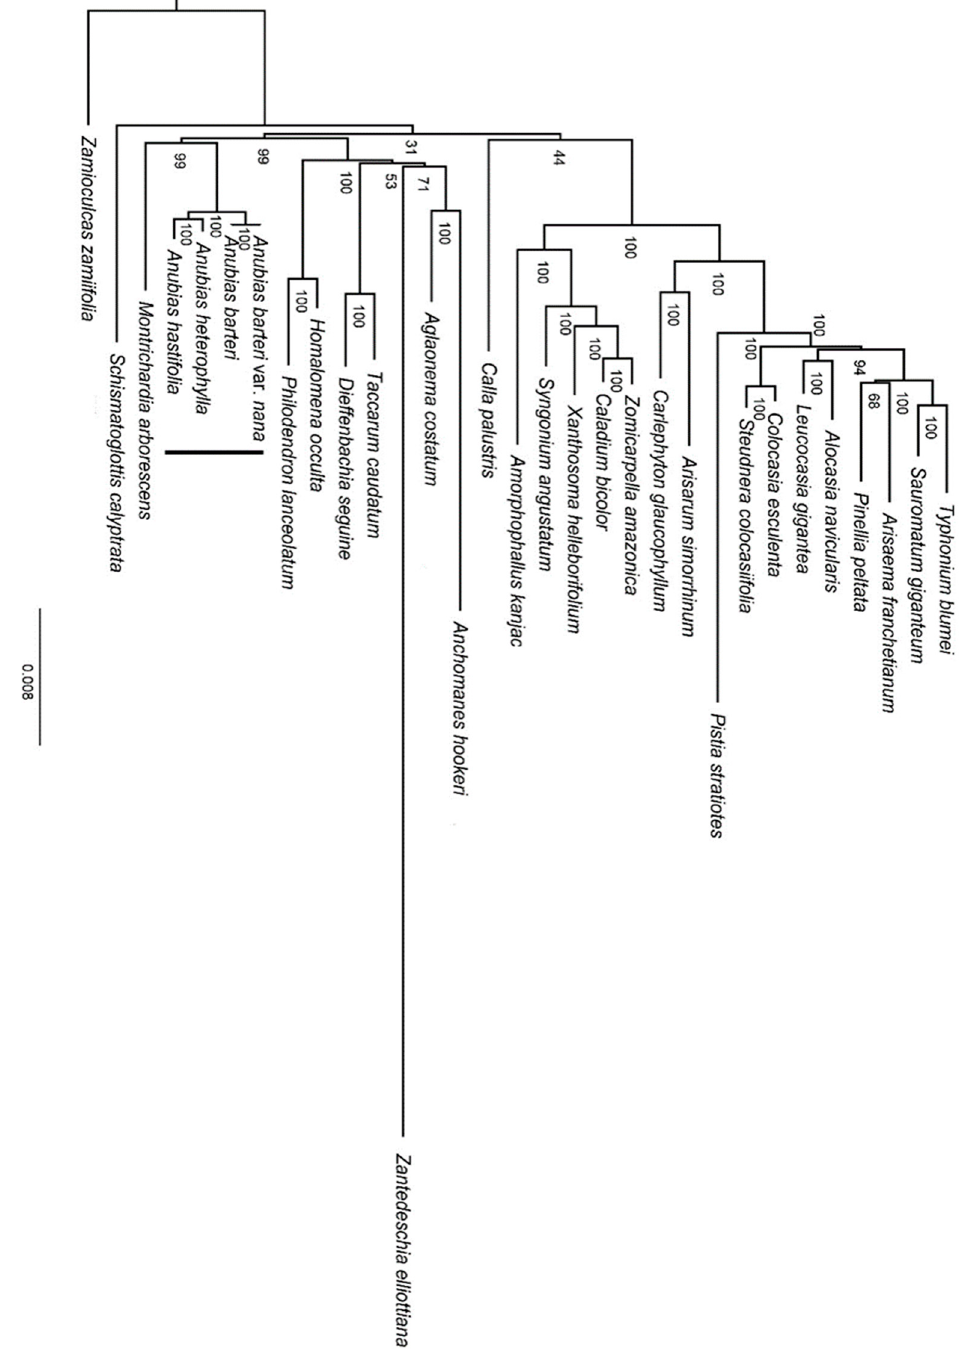
Figure 6. ML phylogenetic tree reconstruction of Anubias and other genera in Araceae based on 75 consensus CDSs.